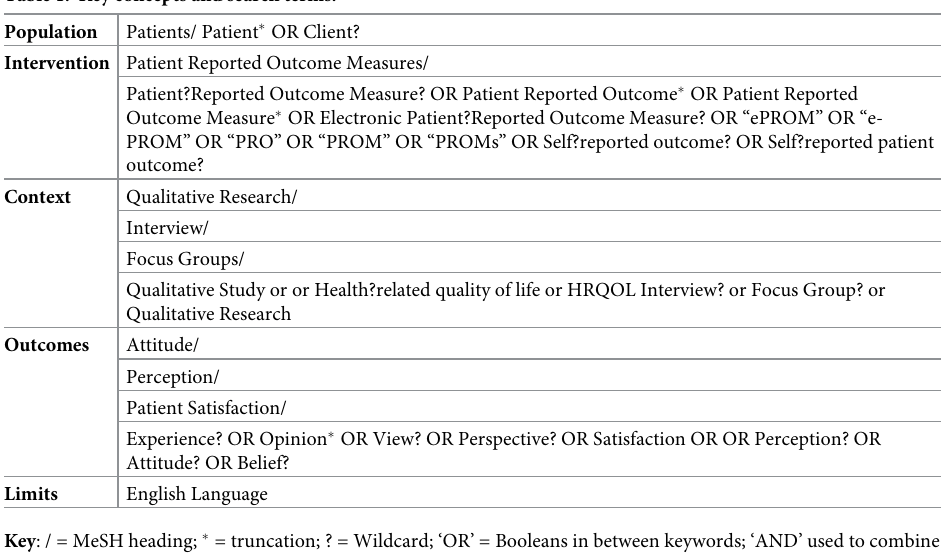
Table 1. Key concepts and search